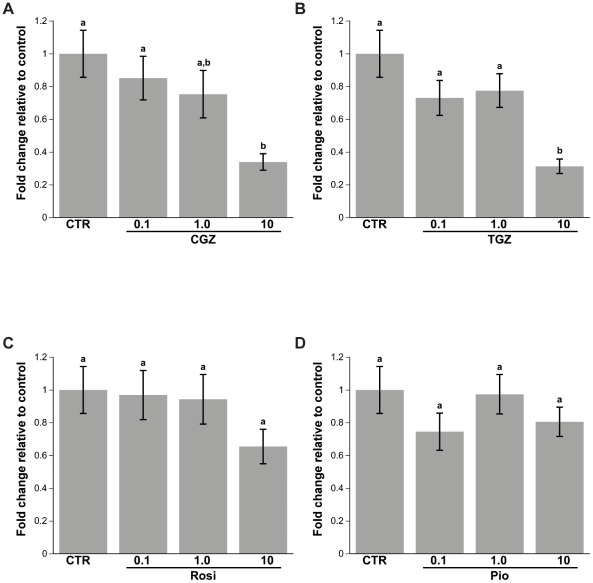
Effect of TZD treatment on Ovcar3 cell proliferation.Ovcar3 cells were serum starved for 24 hours and treated for an additional 24 hours with vehicle control (DMSO) or 0.1, 1.0 or 10 µM of CGZ (A), TGZ (B), Rosi (C), Pio (D). Cell proliferation was assessed with the BrdU assay. Results are the means ± SEM for at least 3 measurements from three individual experiments. Bars that do not share a letter designation are significantly different within a treatment group (p<0.05).